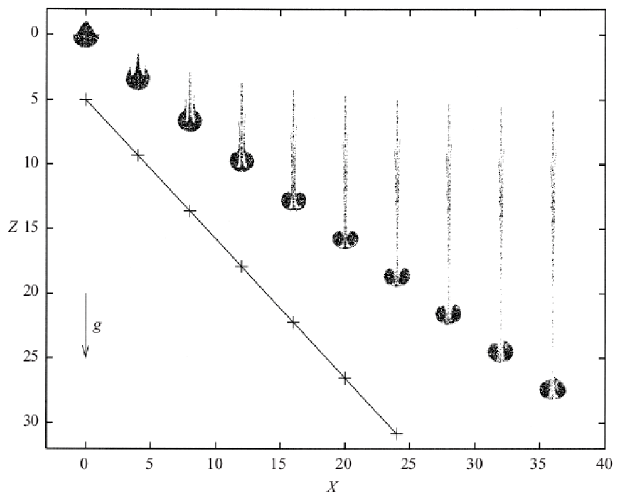
Figure 3: Simulation of Machu et al.